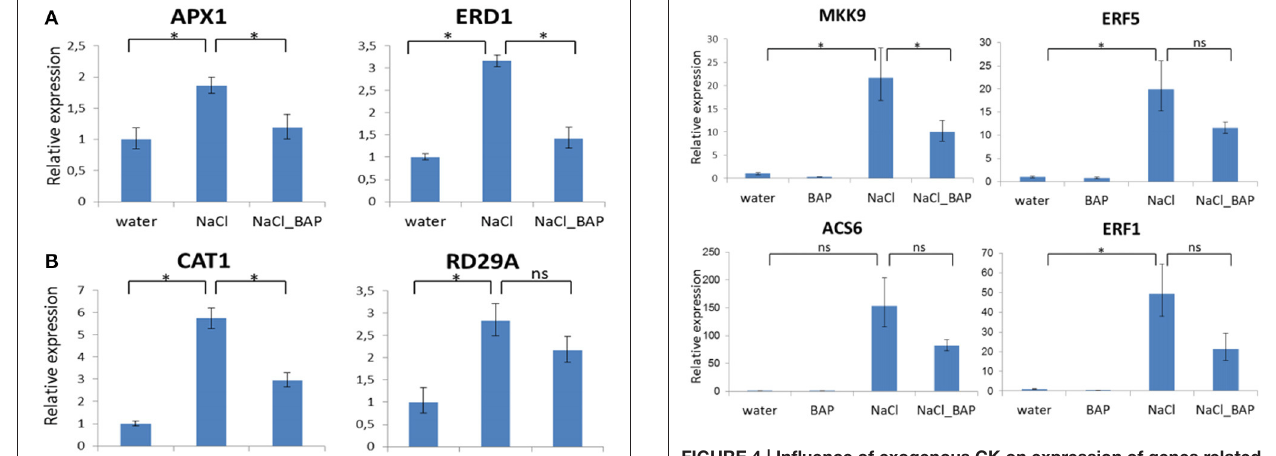
FIGURE 4 | Influence of exogenous CK on expression of genes related to ethylene biosynthesis and signaling during salt stress. Arabidopsis w.t. plants were grown for 30 days in optimal conditions and then leaves were detached and exposed to salinity stress of 120mM NaCl in the presence of CK (BAP) for 24h. Controls were detached leaves in water or BAP treatments. Relative expression of MKK9 , ACS6 , ERF1 , and ERF5 genes was assessed. Samples (3 for each treatment) were collected from controls and stressed leaves. Relative expression was measured by qRT-PCR. Expression of each gene in w.t. control plants was used for comparison (relative expression = 1). Horizontal brackets denote with significance of P < 0.05 (*, statistical significance; ns, no